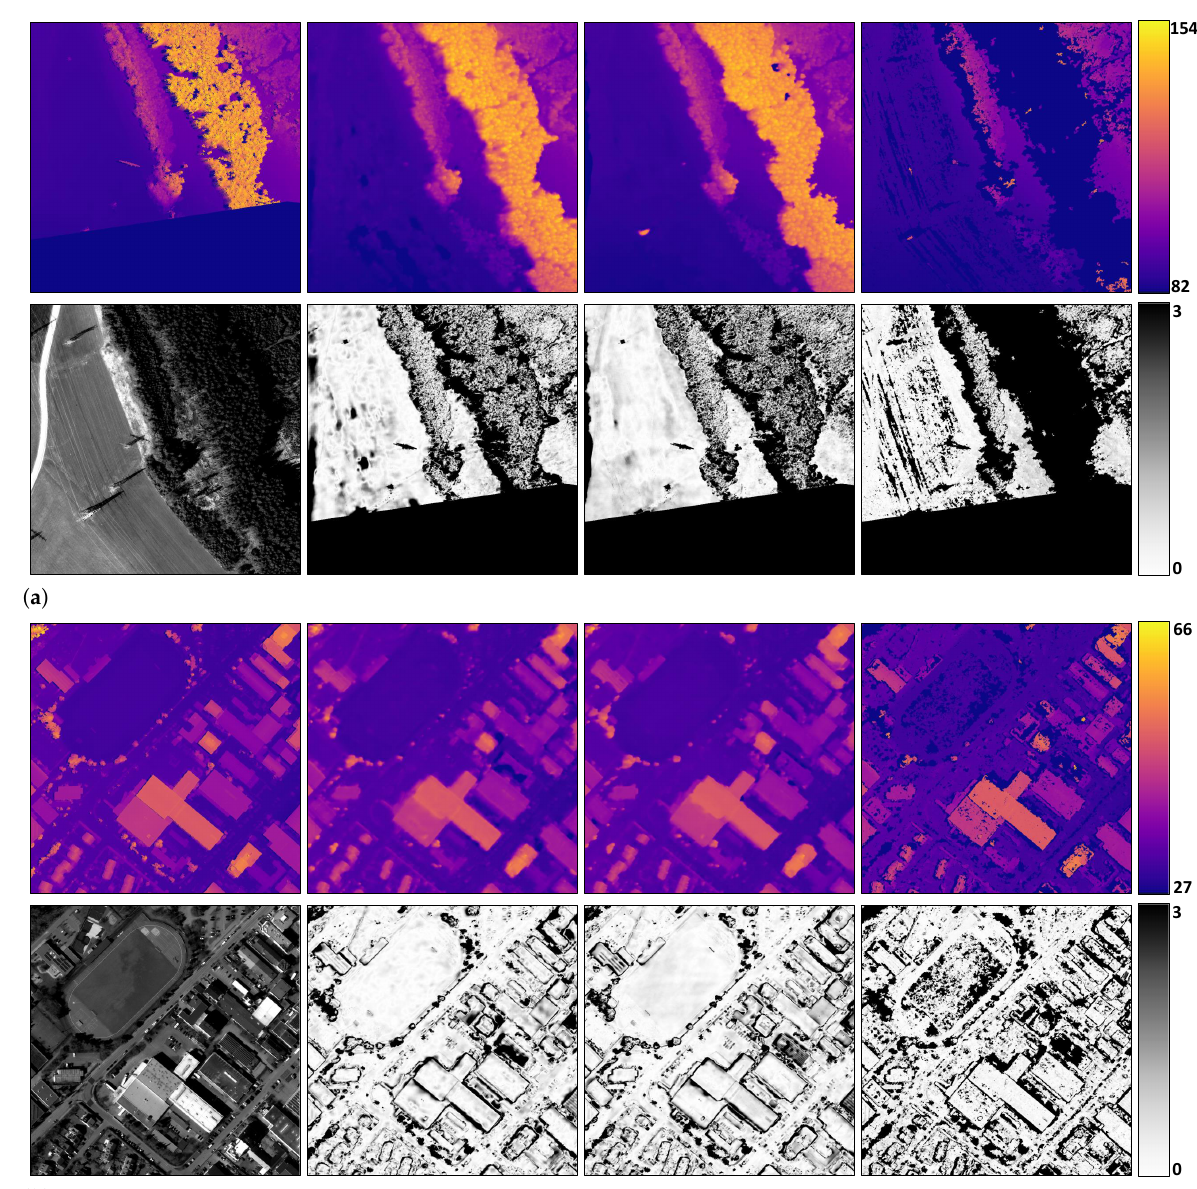
Figure 6. Visual comparison on satellite data. Two test cases regarding vegetation and building area are displayed in subfigure ( a , b ), respectively. In each subfigure, the reference disparity map and the stereo results from GA-Net-PyramidED, GA-Net and SGM are displayed from left to right in the first row. The second row provides the master epipolar image and the corresponding error map of each